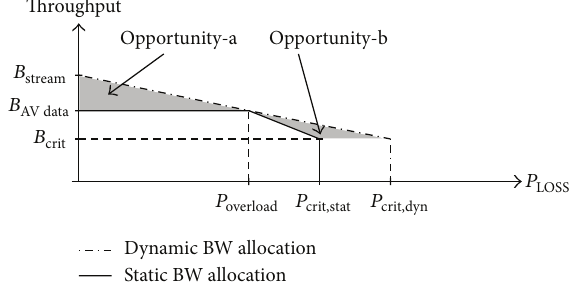
Figure 2: Static versus dynamic bandwidth